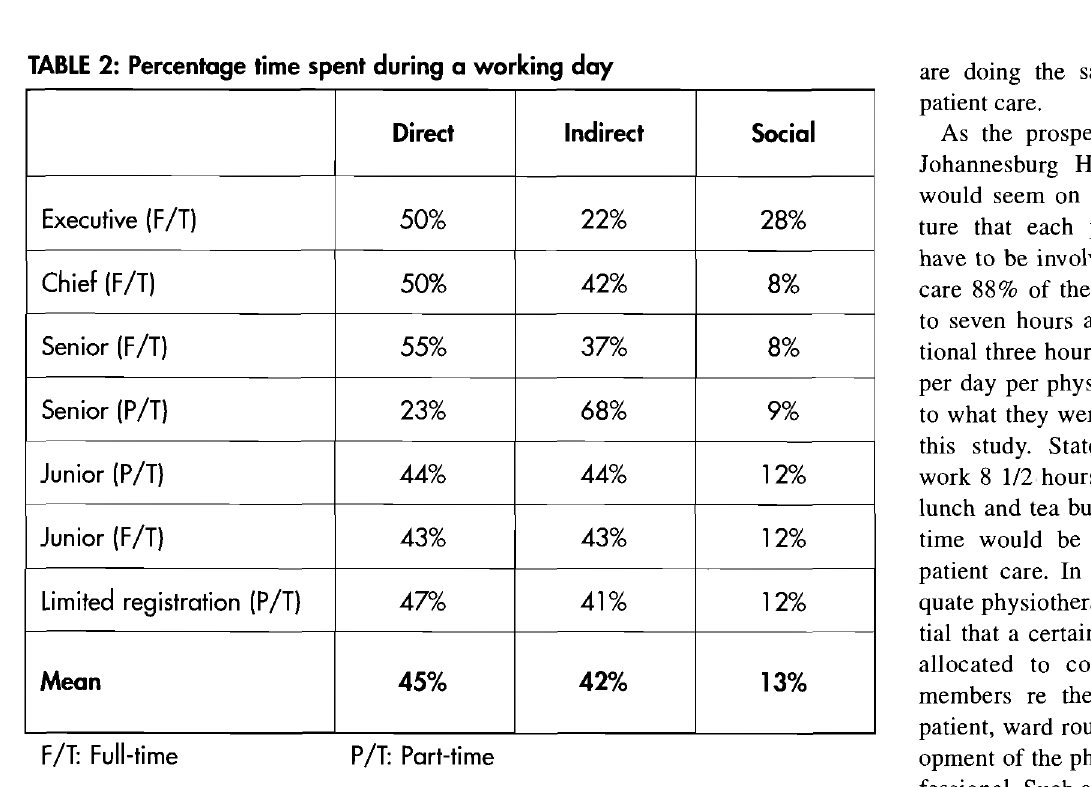
TABLE 2: Percentage time spent during a working day Direct Indirect